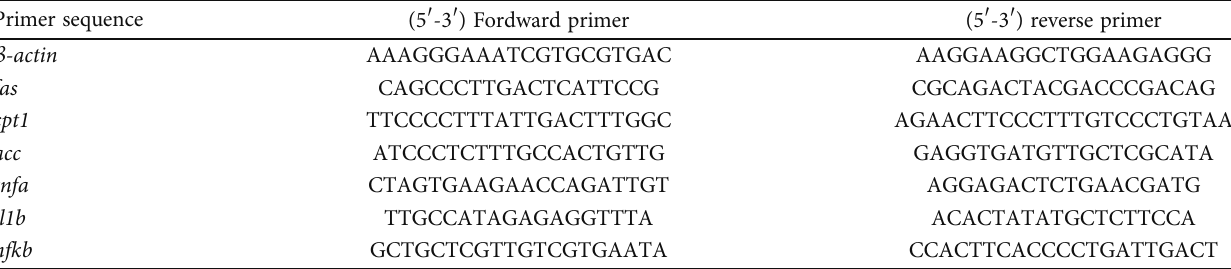
Table 2: Primer sequences for quantitative real-time PCR.